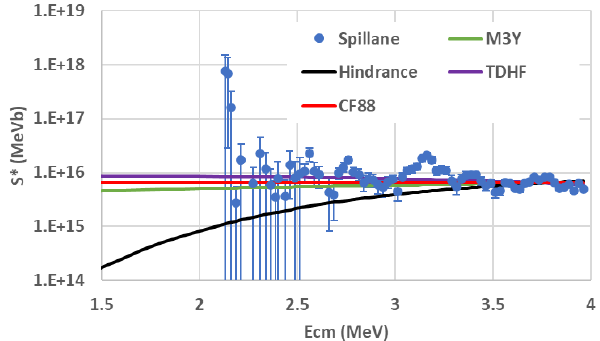
Figure 5. (Color online) The best fits of various models to the experimental S* factor of Spillane in the range of E c . m . = 2.68 to 3.97 MeV. The resulting reduced- χ 2 for the models, M3Y-Rep, Hindrance, TDHF, and CF88, are listed in Table 1.